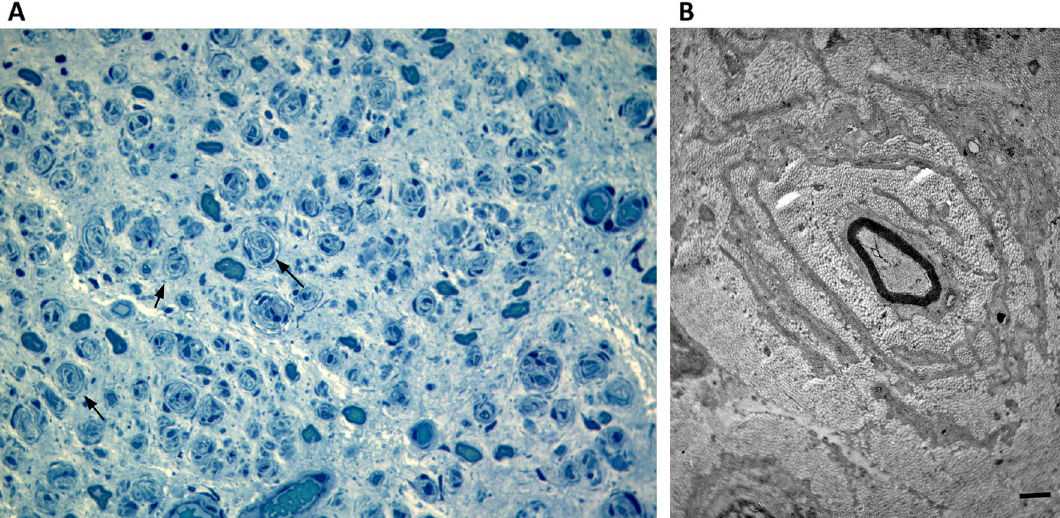
Figure 2. Nerve biopsy of patient carrying the p.K357E variant. ( A ) Sural nerve, semithin section, toluidine blue (400× magnification): several onion bulbs (arrows). ( B ) Electron micrograph; transverse section. One myelinated axon is surrounded by concentric proliferation of Schwann cells. Bar = 1